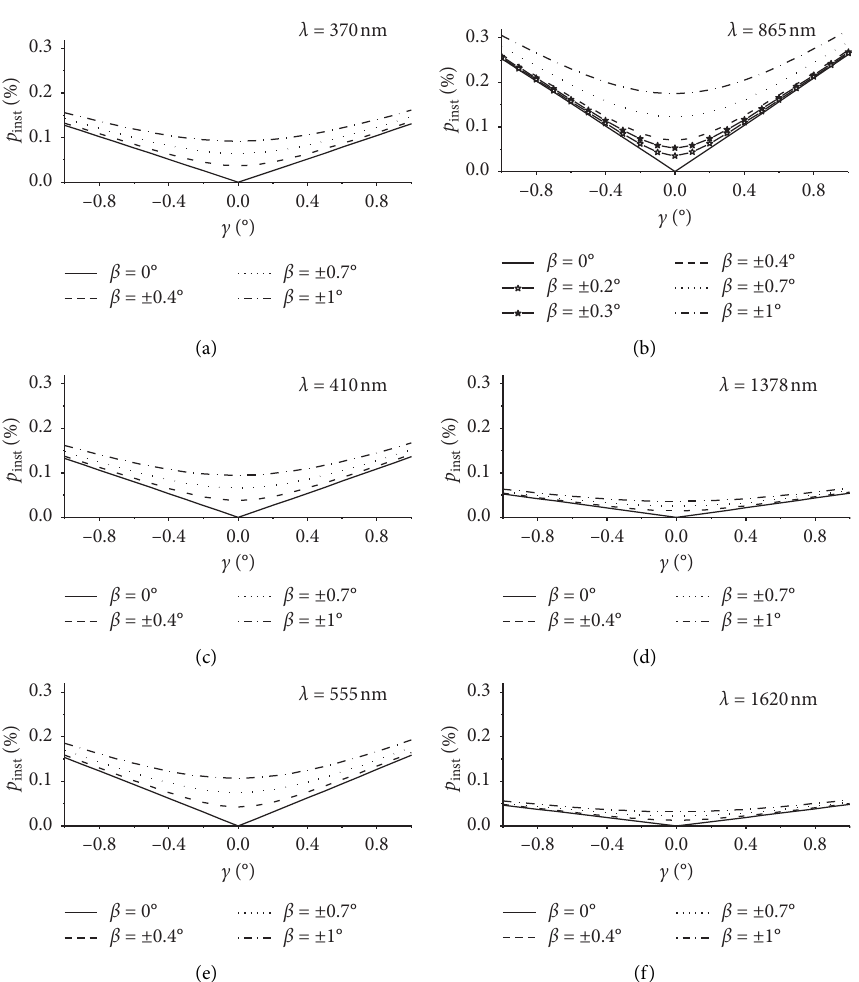
inst of the instrumental polarization of the TSM on the mirror M 2 tilt around